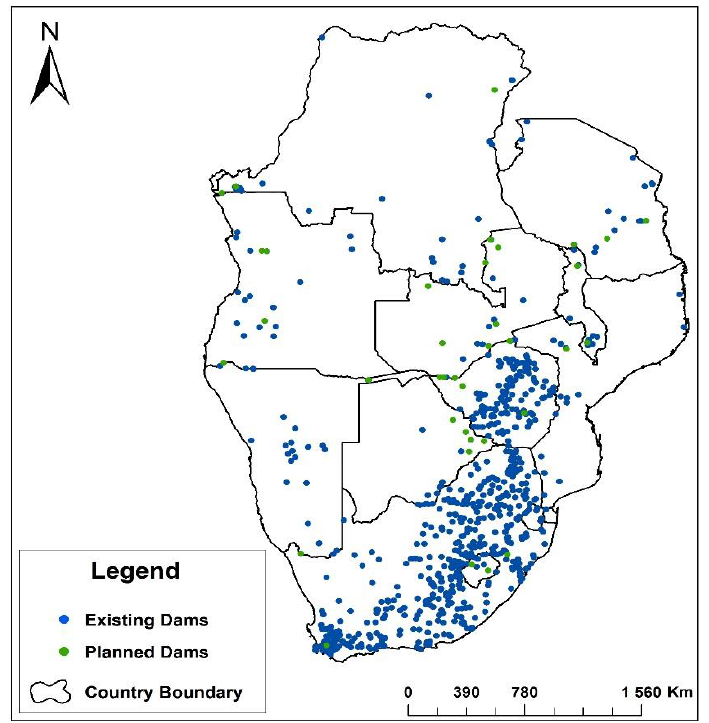
Figure 3. Existing and proposed dams in southern Africa. Source: Developed by authors from FAO Aquastat data [25].